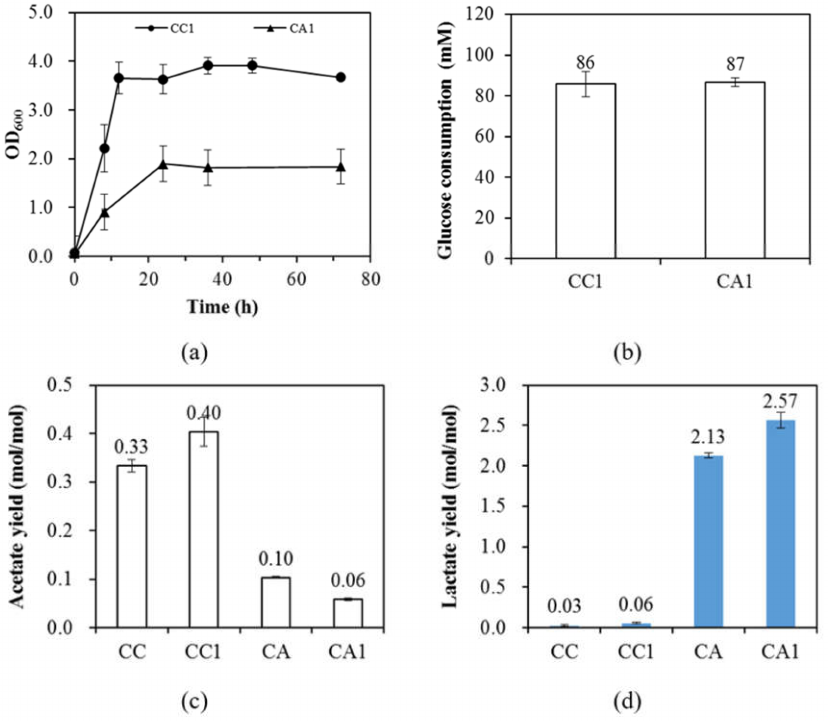
Figure 2. ( a )The growth curve and ( b ) glucose consumption of E. coli strains CC1 and CA1. ( c ) The acetate and ( d ) lactate yields of E. coli strains CC, CC1, CA, and CA1. M9 minimal salts with 111 mM glucose and 2 g / L yeast extract was used. The standard deviation was used for the error with n (biological replicates) ≥ 3. The genotypes of CC and CA are MZLF ( ∆ ppc ), and MZLF ( ∆ ppc , ∆ pta ), respectively. The nomenclature 1 of CC1 and CA1 represents strains CC and CA harboring P BAD -his6- prkA -pACYC184. The genes ppc and pta encodes phosphoenolpyruvate carboxylase and phosphate acetyltransferase,